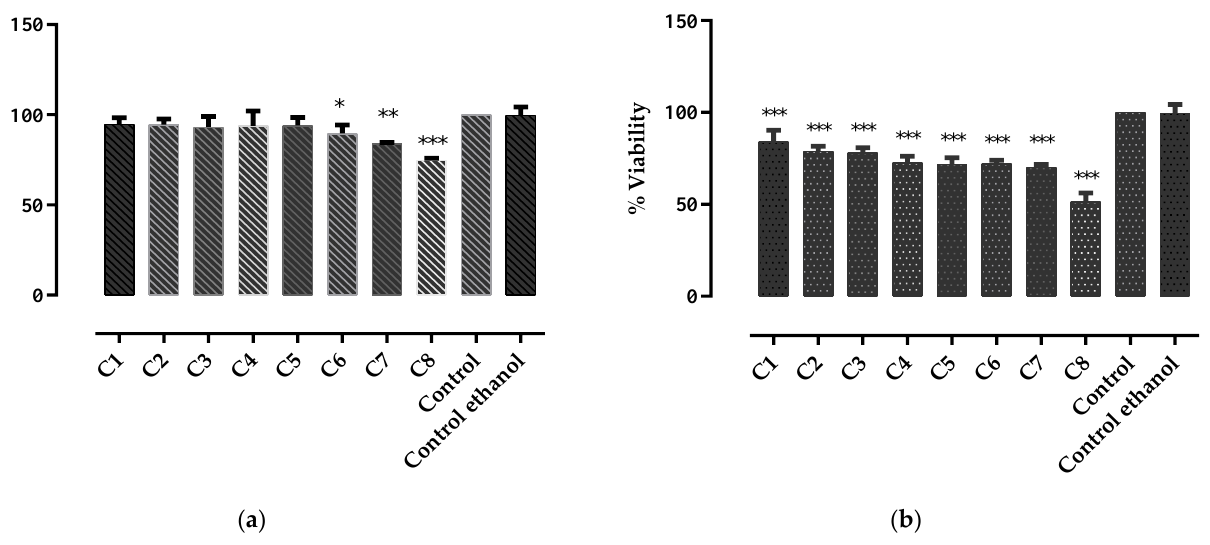
Figure 2. Inhibitory effects of ( a ) G. asclepiadea and ( b ) I. helenium root extracts on rat intestinal epithelial cells, at eight different concentrations C1–C8 calculated according to the TPC (μmol GAE/mL extract): ranging between 0.0079 and 0.4786 for G. asclepiadea extract, and from 0.0135 to 0.8068 for